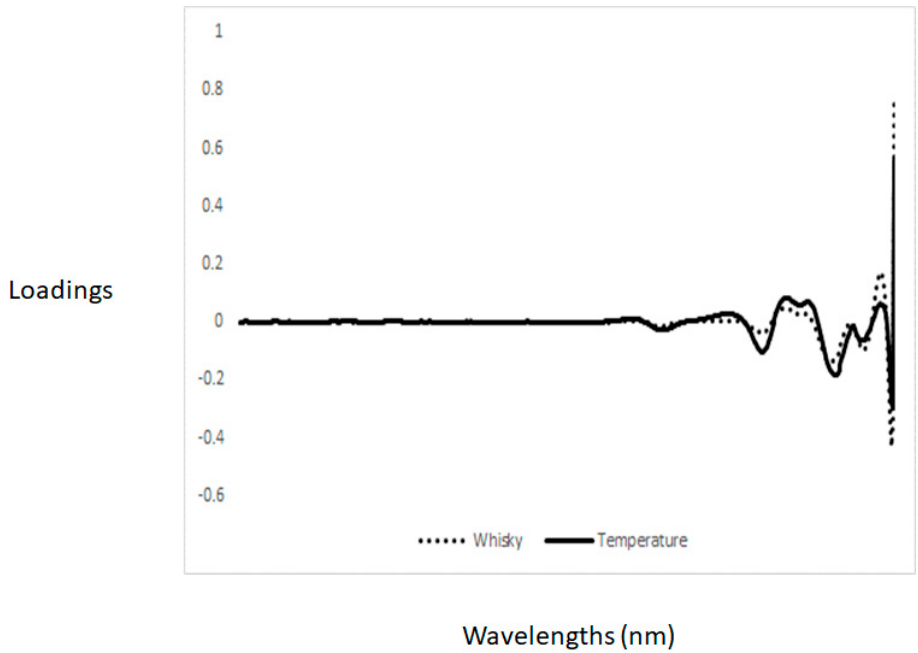
Figure 6. Partial least squares (PLS-DA) loadings derived from the prediction of origin and temperature in the whisky samples analysed using UV-VIS spectroscopy.